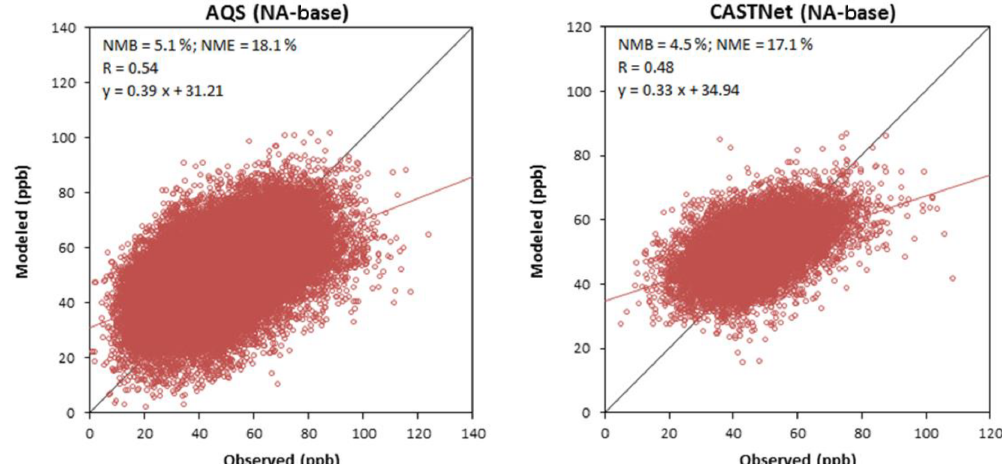
Figure 5. Scatter plots of modeled MDA8 O 3 concentrations from the CAMx base case vs. observations at AQS and CASTNet sites for March–September 2010. The black and red lines are one-to-one and linear regression lines, respectively. Normalized mean bias (NMB) and normalized mean error (NME) were calculated with no